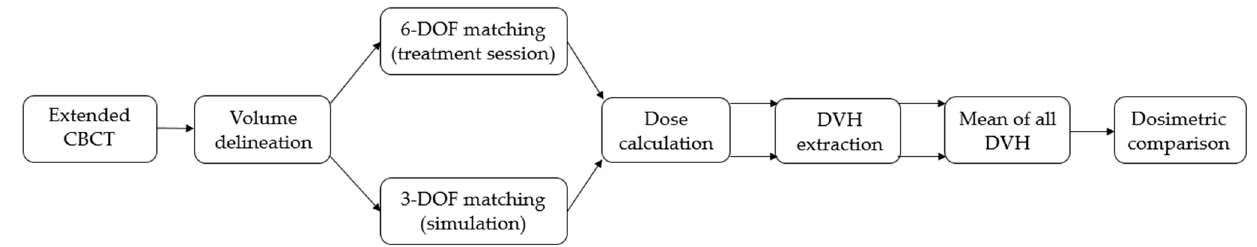
Figure 1. Workflow of the dosimetric comparison between 6-DOF and 3-DOF CBCT plans